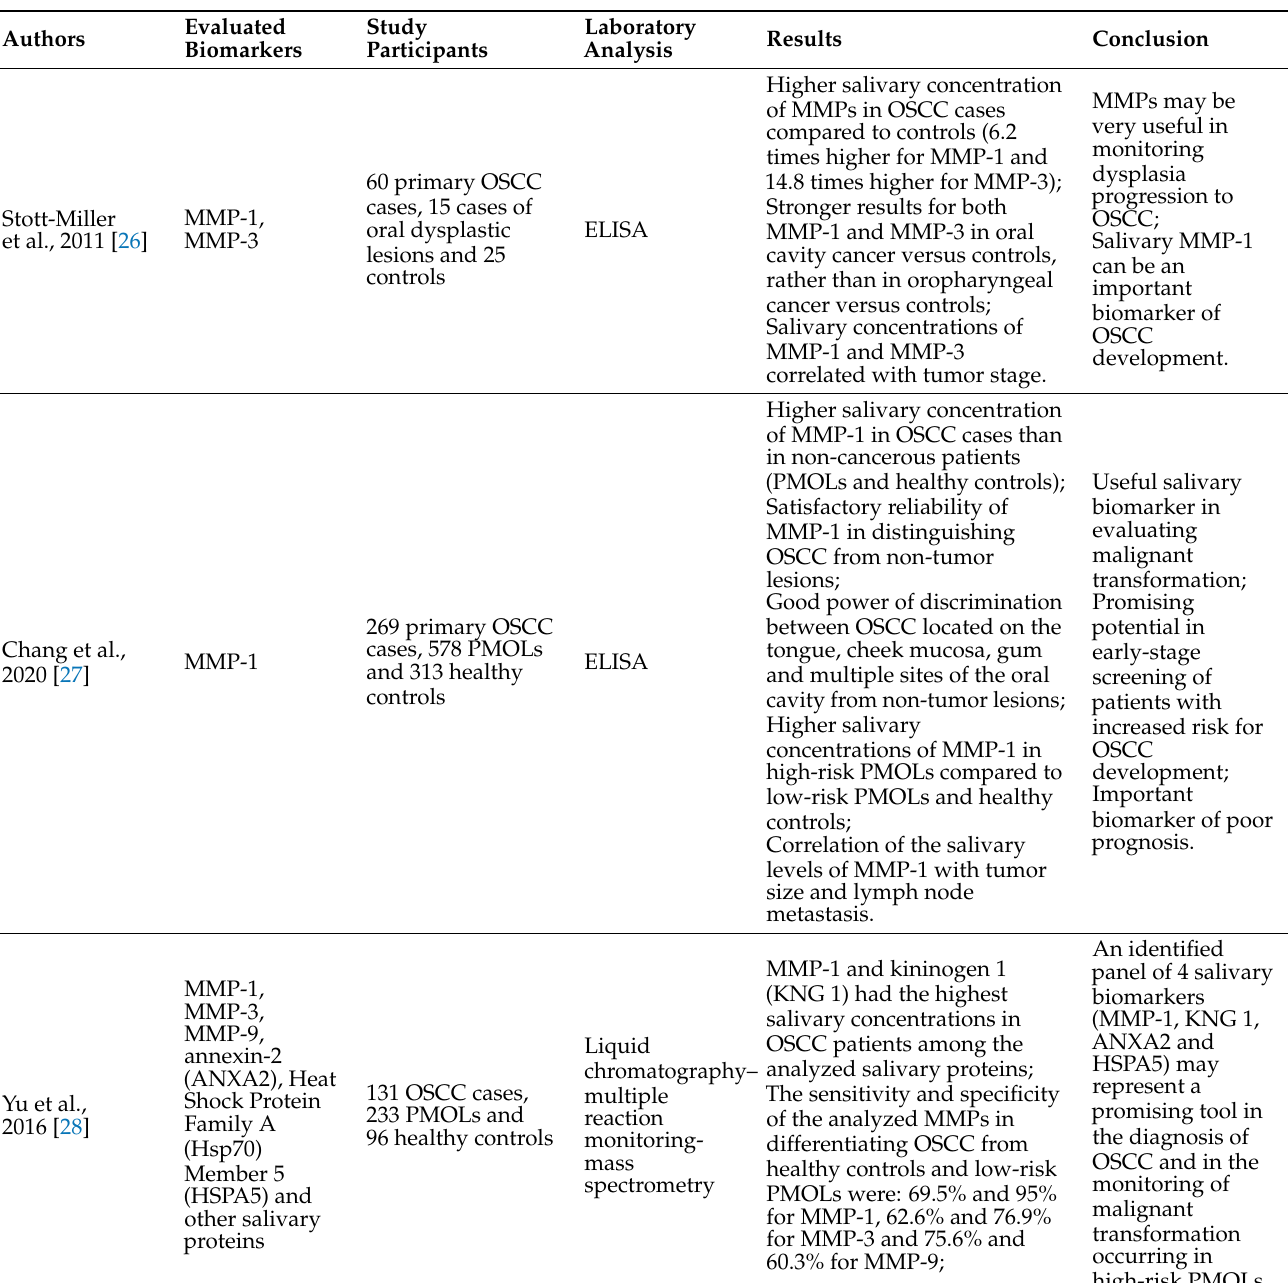
Table 1. Clinical findings of the reviewed